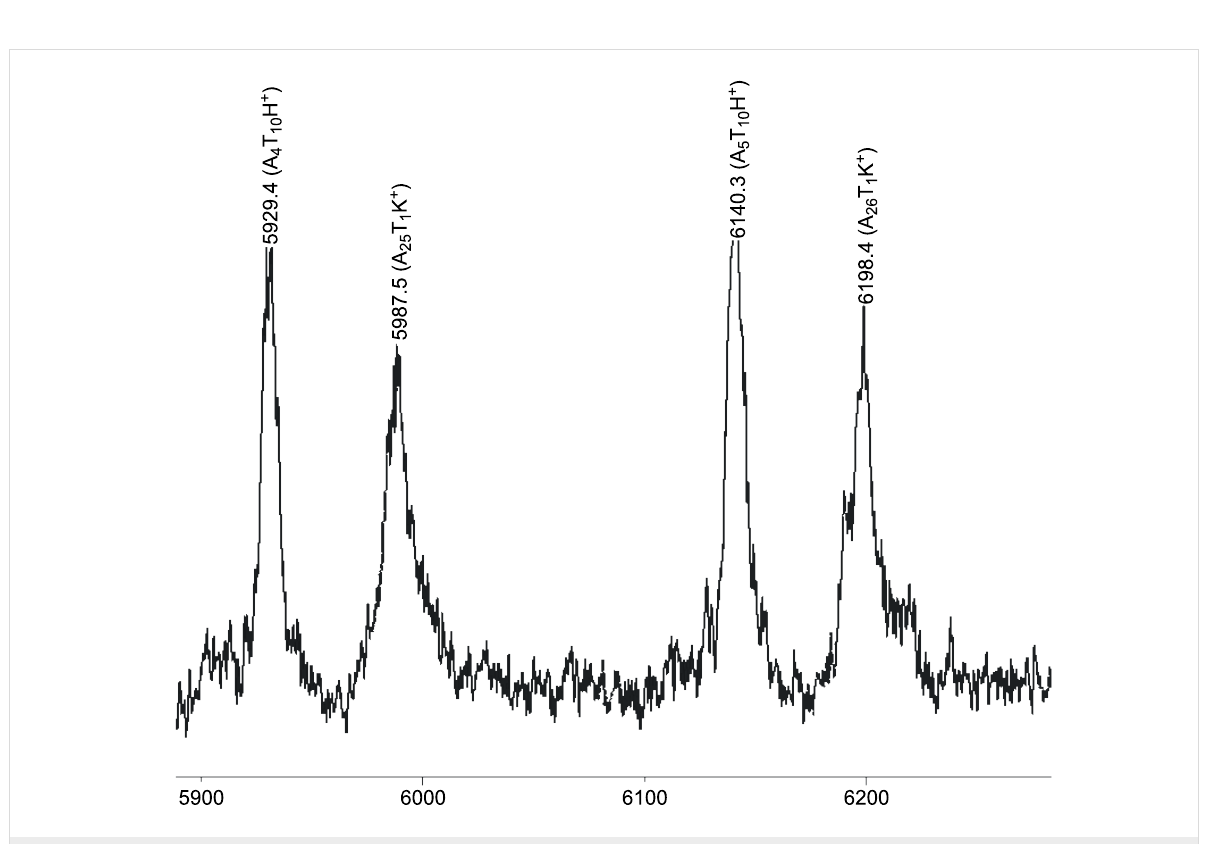
Figure 11: MALDI-TOF mass spectrum of BCP-A 25 T 25 synthesized with catalyst U3